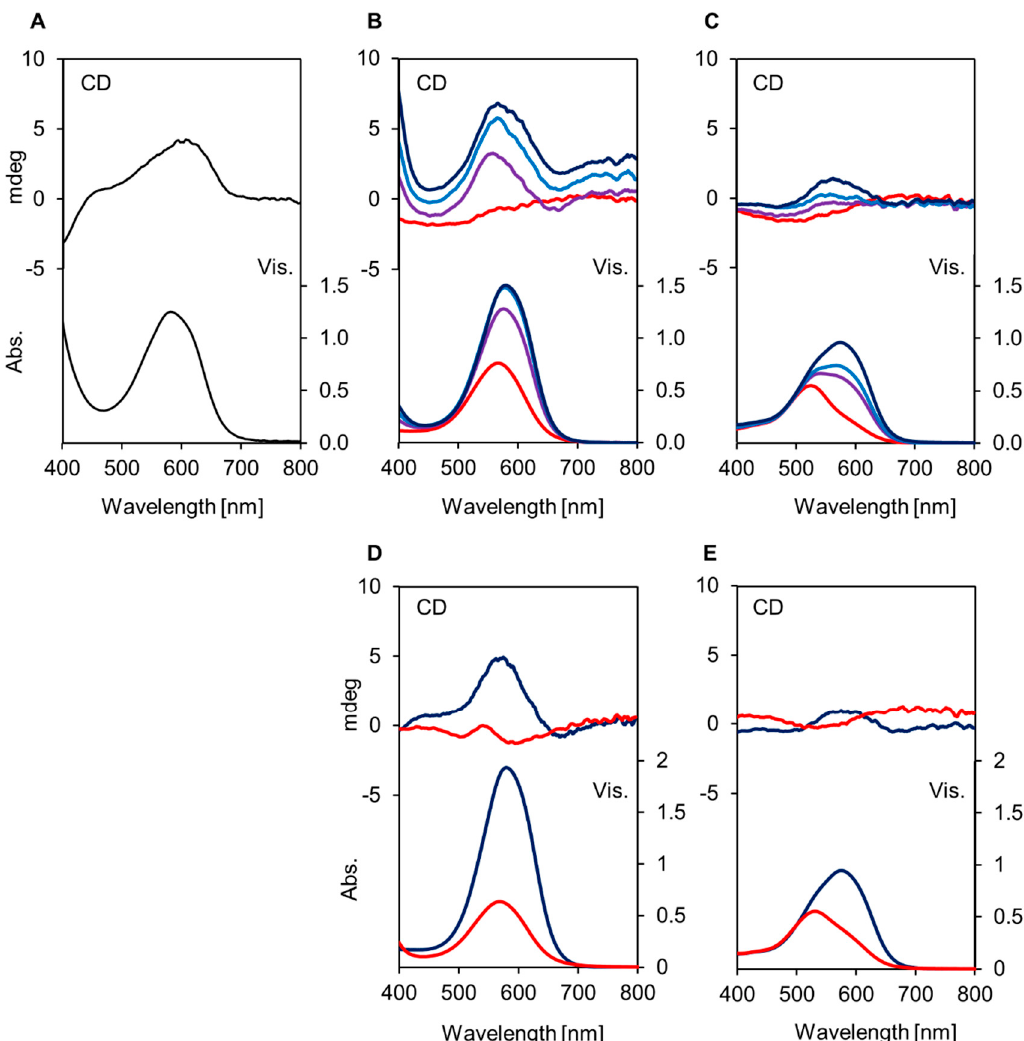
Figure 2. Visible and CD spectra of reproduced solutions by mixing 1 (Dp3G, 0.1 mM) and Al 3+ (1 eq.) with 0-3 eq. of co-pigment, 5CQ ( 2 ), 5 p CQ ( 3 ), or 3CQ ( 4 ) in buffered solutions of 2 mM. ( A ) Cell sap obtained from blue hydrangea sepals. ( B ) With 5CQ ( 2 ) at pH 4.0. — : 0 eq., — : 1 eq., — : 2 eq., — : 3